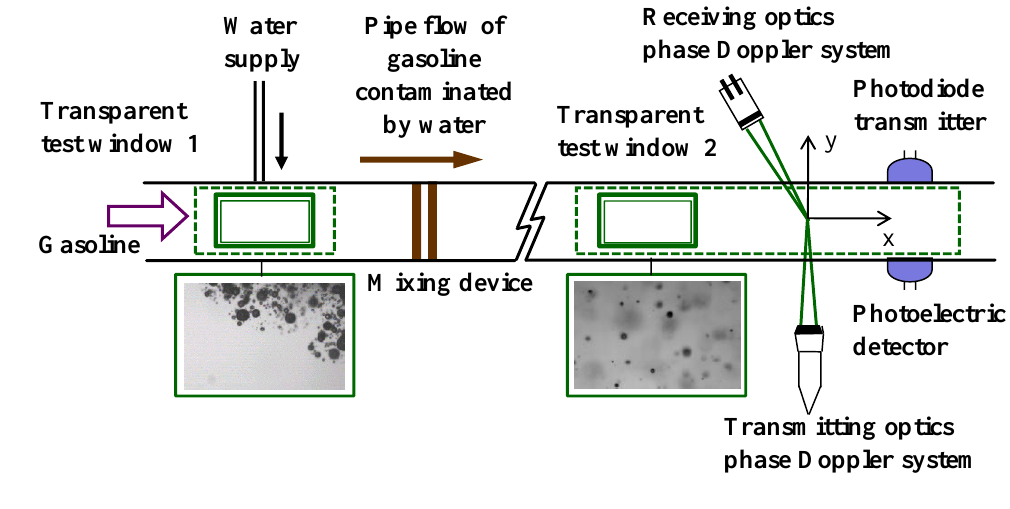
Figure 1. Schematic diagram of experimental